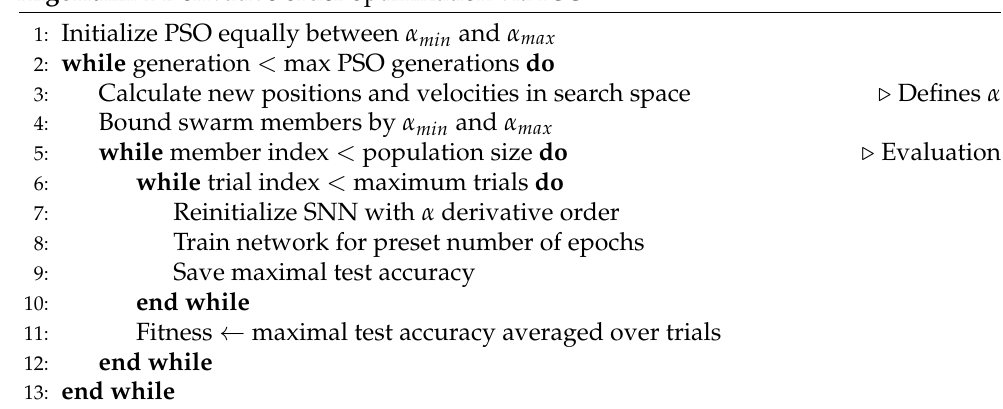
Algorithm 1 Derivative order optimization via